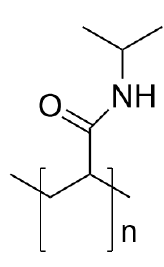
Figure 6. A schematic representation of LCST and UCST concepts and the polymer properties. Created in Biorender.com, accessed date (9 February 2022).